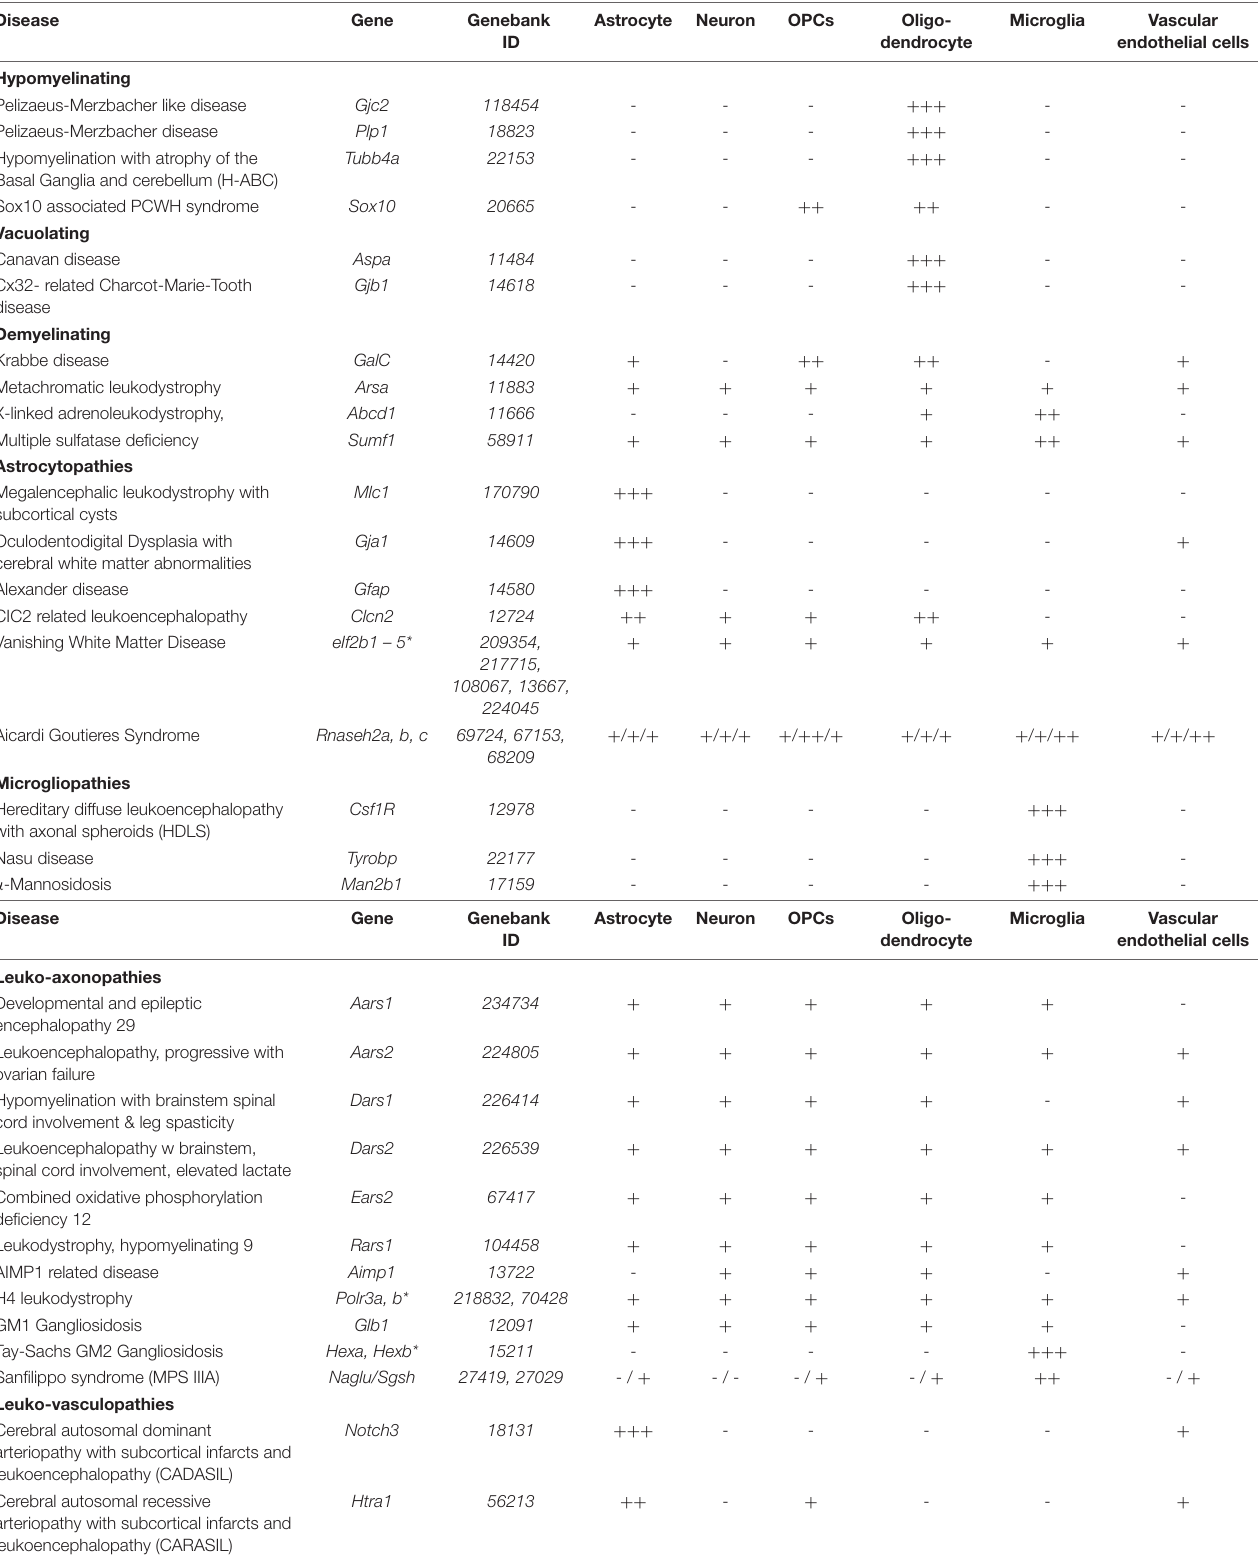
TABLE 2 | Gene expression of leukodystrophy associated genes across neural cell types.